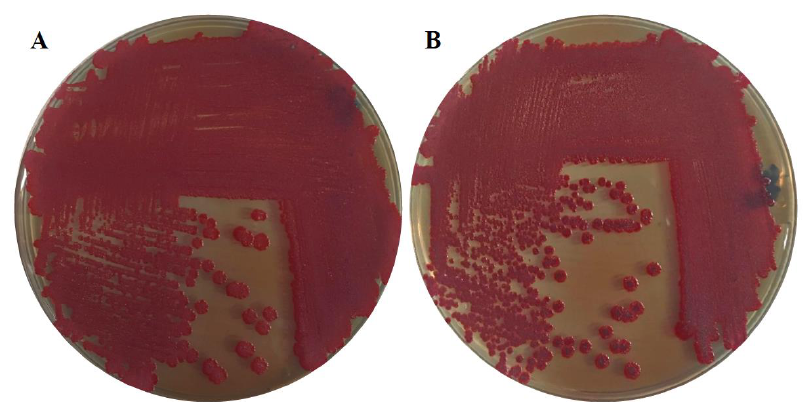
Figure 2. E. ludwigii urinary catheter isolate CEB04 grown on LB without salt agar plates containing Congo red and Coomassie brilliant blue. Plates were incubated for 48 h at 28 °C ( A ) and 37 °C ( B ). Table 1. Biofilm characteristics of E. ludwigii CEB04.